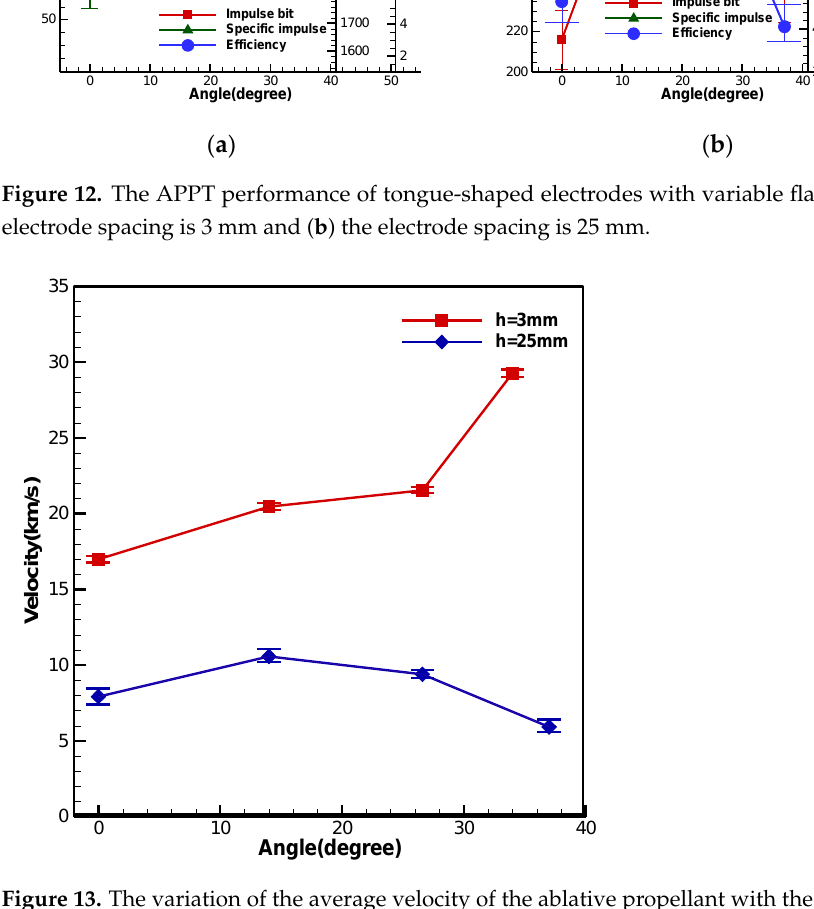
Figure 13. The variation of the average velocity of the ablative propellant with the flare angle of the tongue-shaped electrode.